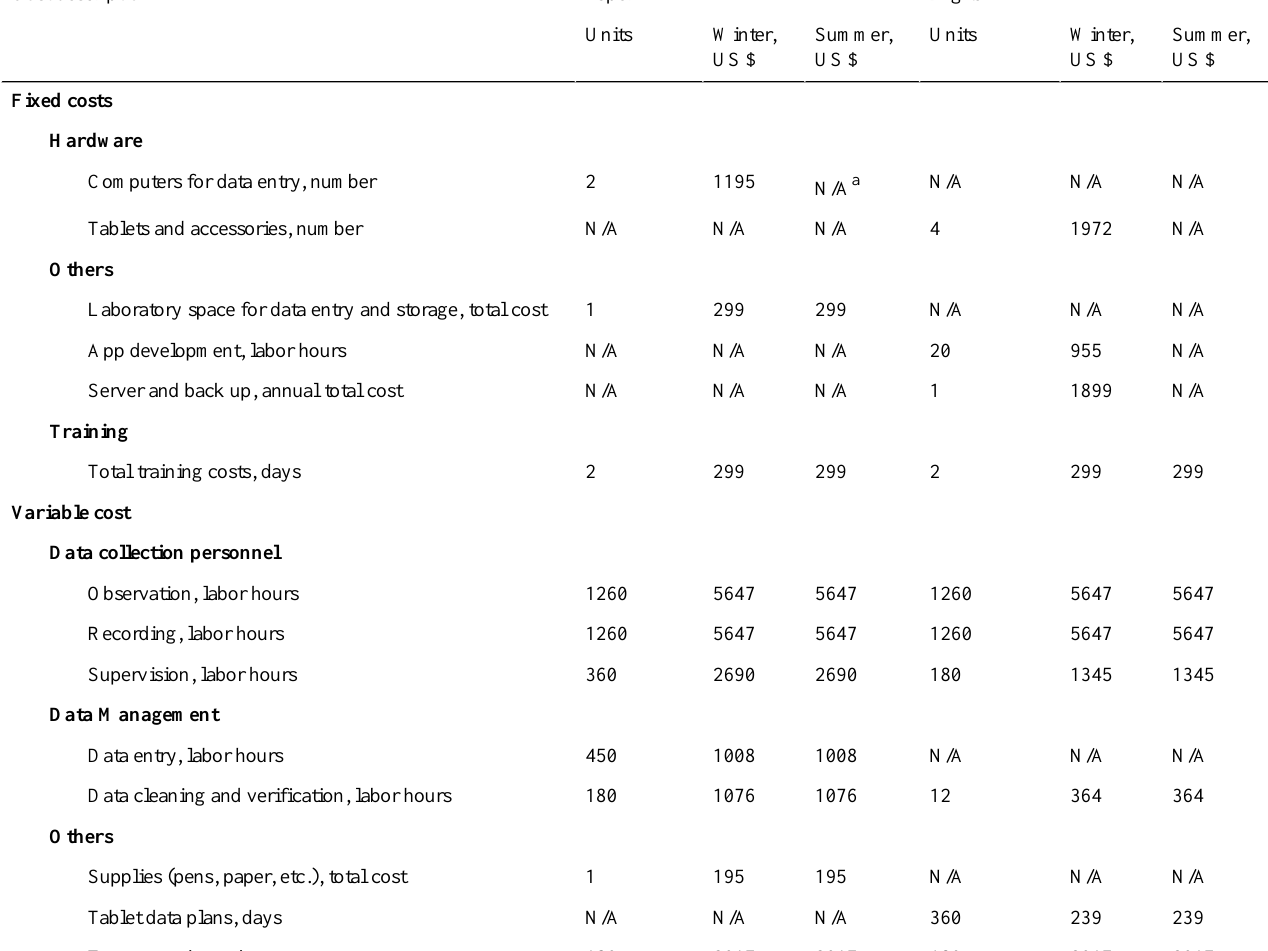
Table 4. Cost comparison between paper and digital data collection across rounds of data collection in US